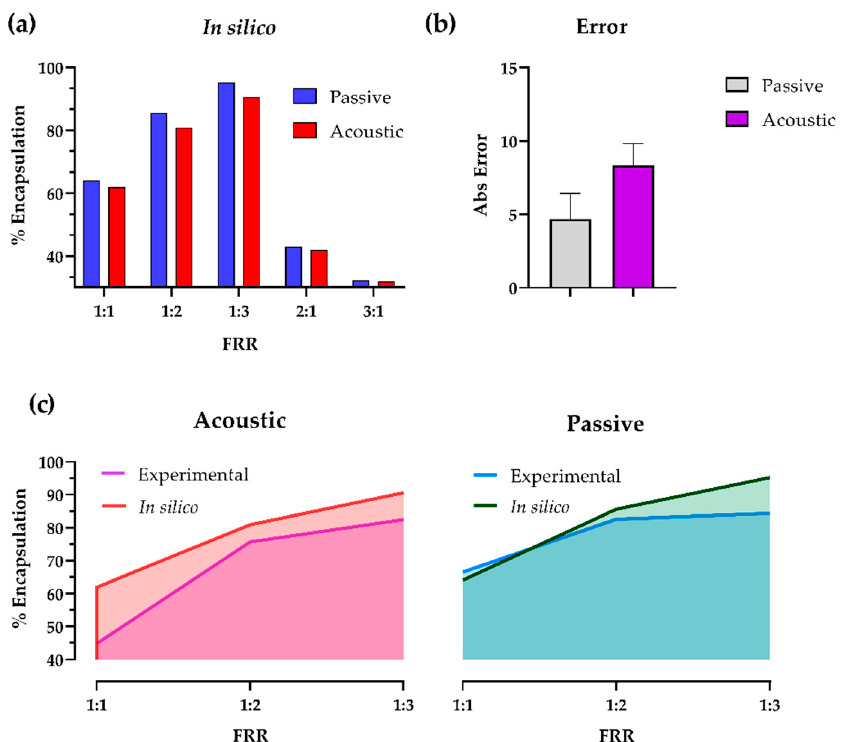
Figure 9. In silico and experimental encapsulation efficiency evaluation of nanoconjugates into liposomes at different flow rate ratios. ( a ) In silico evaluation for active and acoustic encapsulation methods; ( b ) Absolute error of the predicted in silico encapsulation efficiency; ( c ) In silico and experimental comparison between active and acoustic encapsulation efficiencies for different flow rate ratios (FRRs).